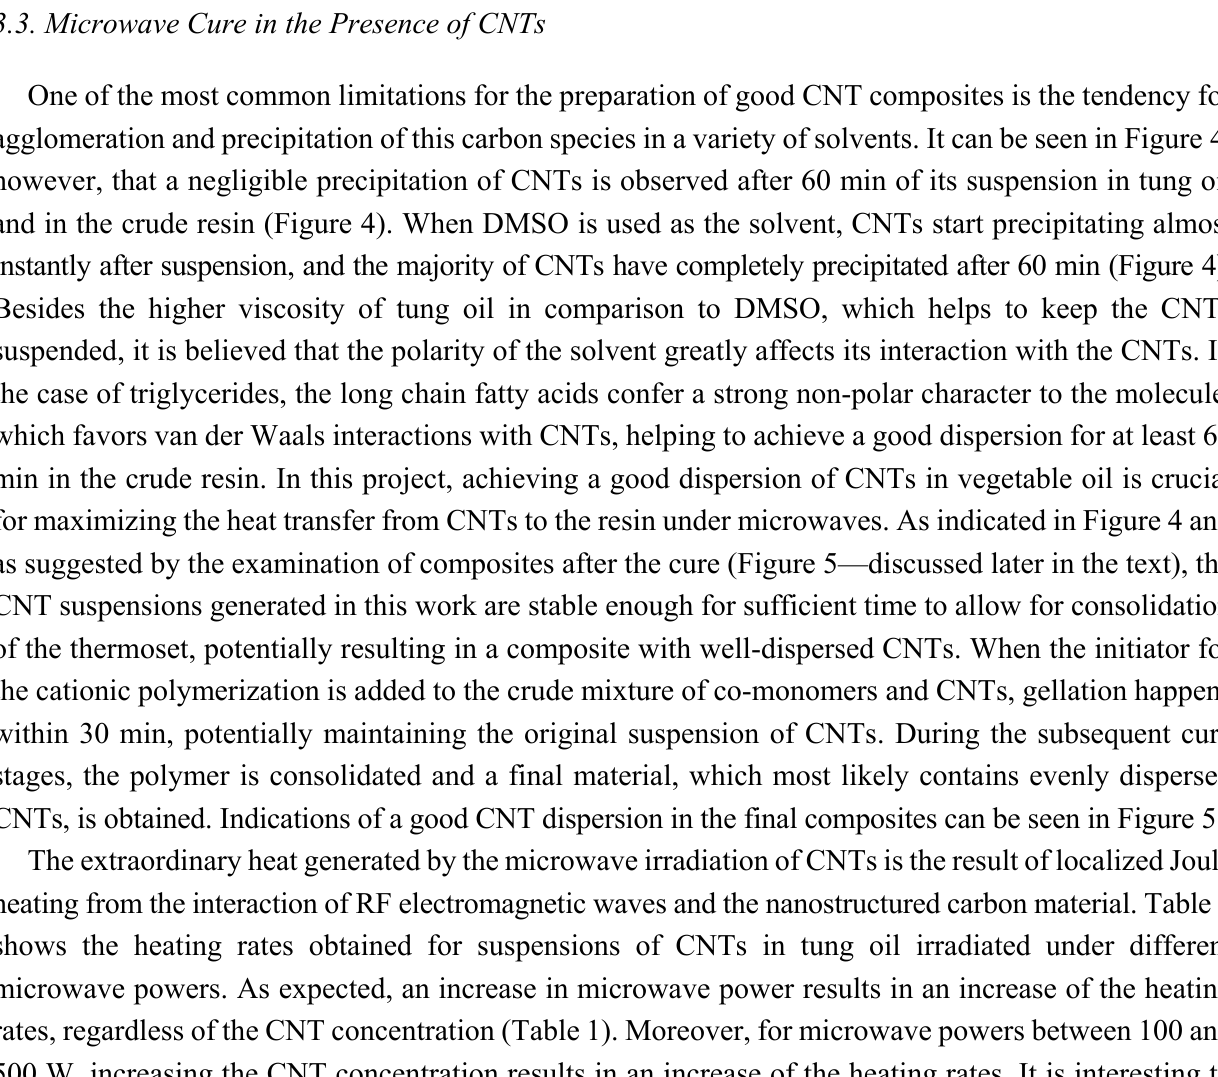
Figure 3. Differential scanning calorimetry (DSC) curves of tung oil-based thermosetting resins cured for 1.5 h, 3.5 h, 5.5 h, and 6 h at 140 °C. The resin is composed of 70 wt % of tung oil, 15 wt % of DVB, 10 wt % of ST, 3 wt % of soybean oil, and 2 wt % of BF 3 ·OEt 2